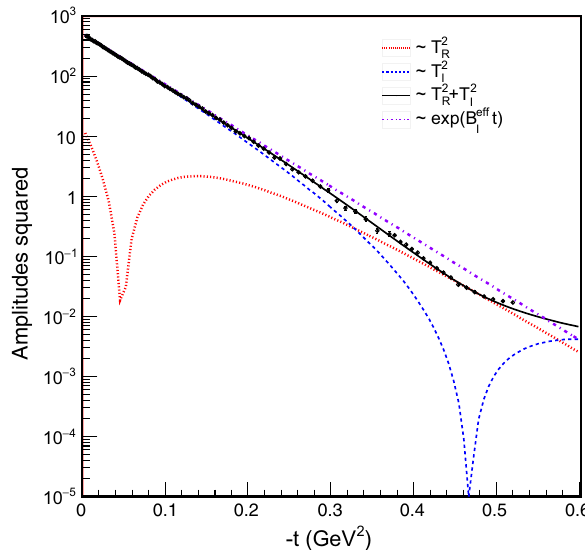
Fig. 6 Comparison of the squared magnitudes of real, imaginary and simplified single exponential amplitudes for the extended T7 dataset, with 104 experimental points (full circles). The real amplitude has a zero near 0.04 GeV 2 and its magnitude competes with the imaginary amplitudefrom | t | = 0 . 3GeV 2 .Theimaginaryamplitudedeviatesfrom simple exponential form near | t | ∼ 0 . 2 GeV 2 and passes through zero at | t | = 0 . 47 GeV